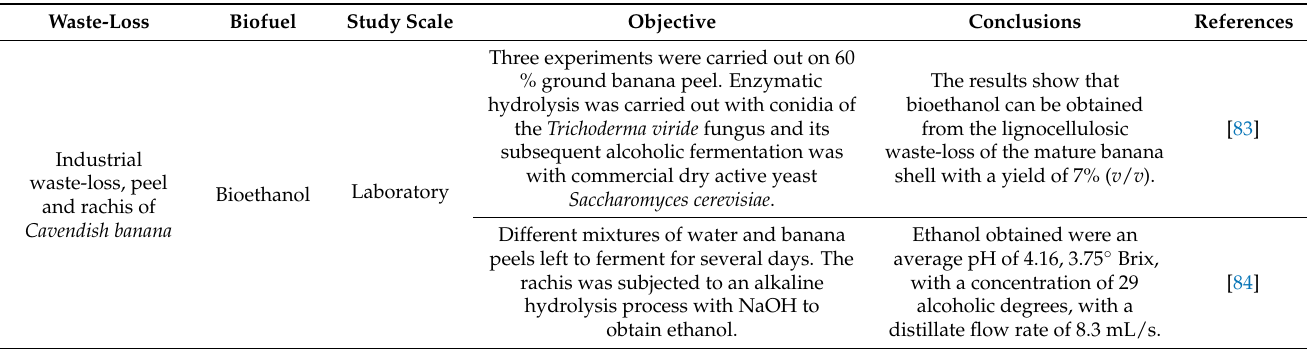
Table 6. Biofuel production studies using banana